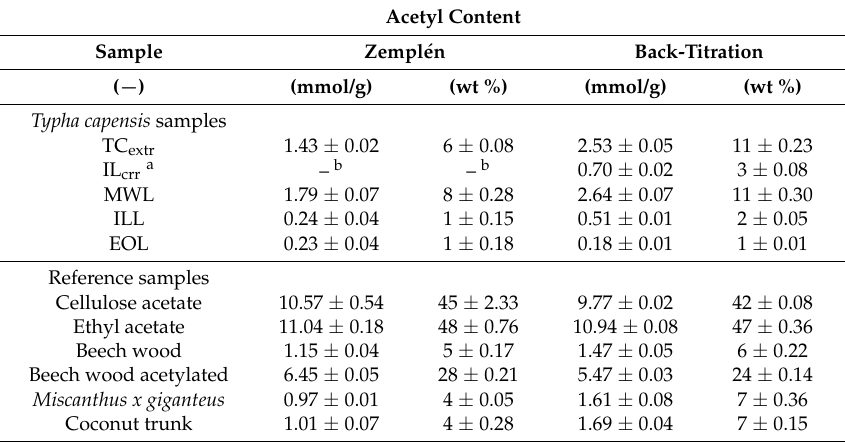
Table 1. Acetyl group contents of Typha capensis based samples and some reference samples determined by Zempl é n transesterification reaction in comparison with back-titration values.